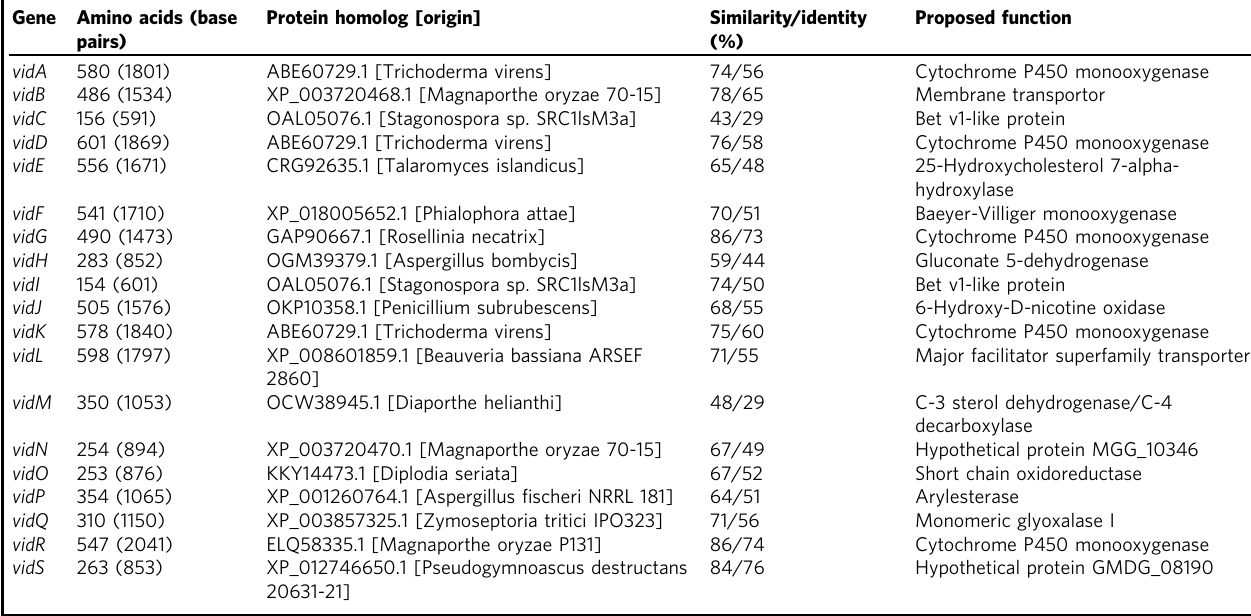
Table 1 Putative functions of genes in the vid cluster Gene Amino acids (base Protein homolog pairs)